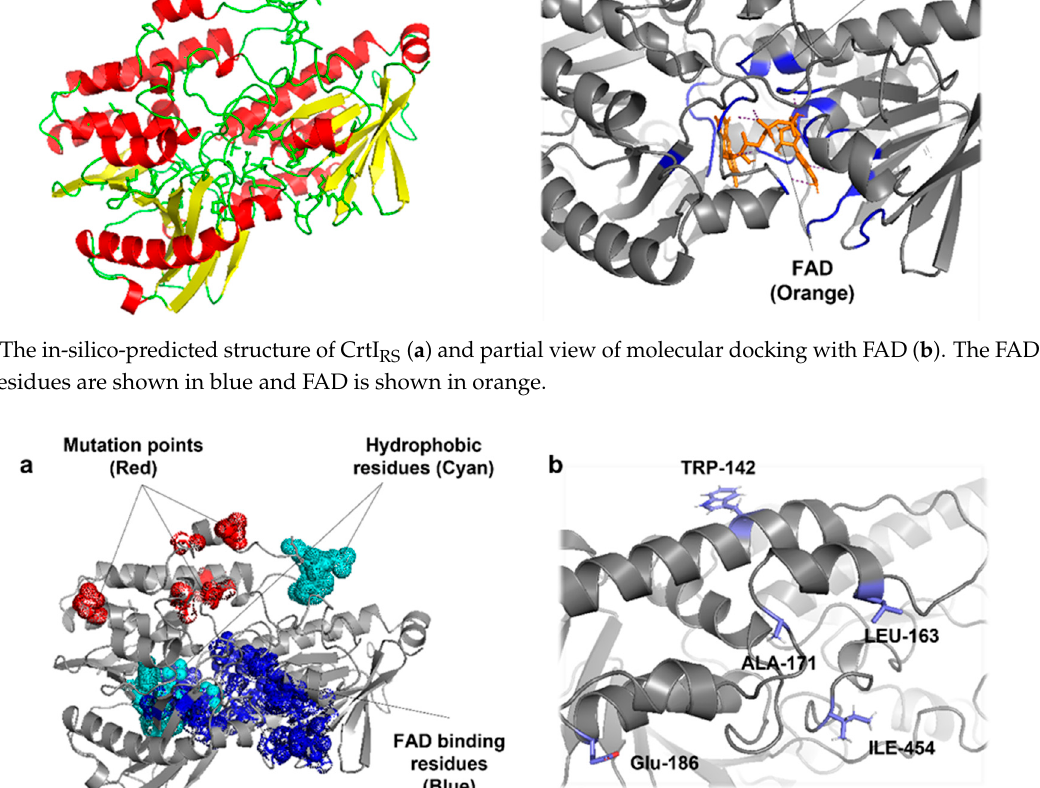
Table 3. Primers used in this study. The underlined sections indicate restriction enzyme sites. Gene Primer Sequence Enzyme Site F: 5 ′ GCTCTAGAAGGAGGATTACAAAATGGCGTTTGAACAGCGGATTG 3 ′ Xba Ⅰ crtE R: 5 ′ GGAATTCTCAGACGCGGGCCGCGACCT 3 ′ EcoR Ⅰ F: 5 ′ GGAATTCAGGAGGATTACAAAATGATTGCCTCTGCCGATCT3 ′ crtB